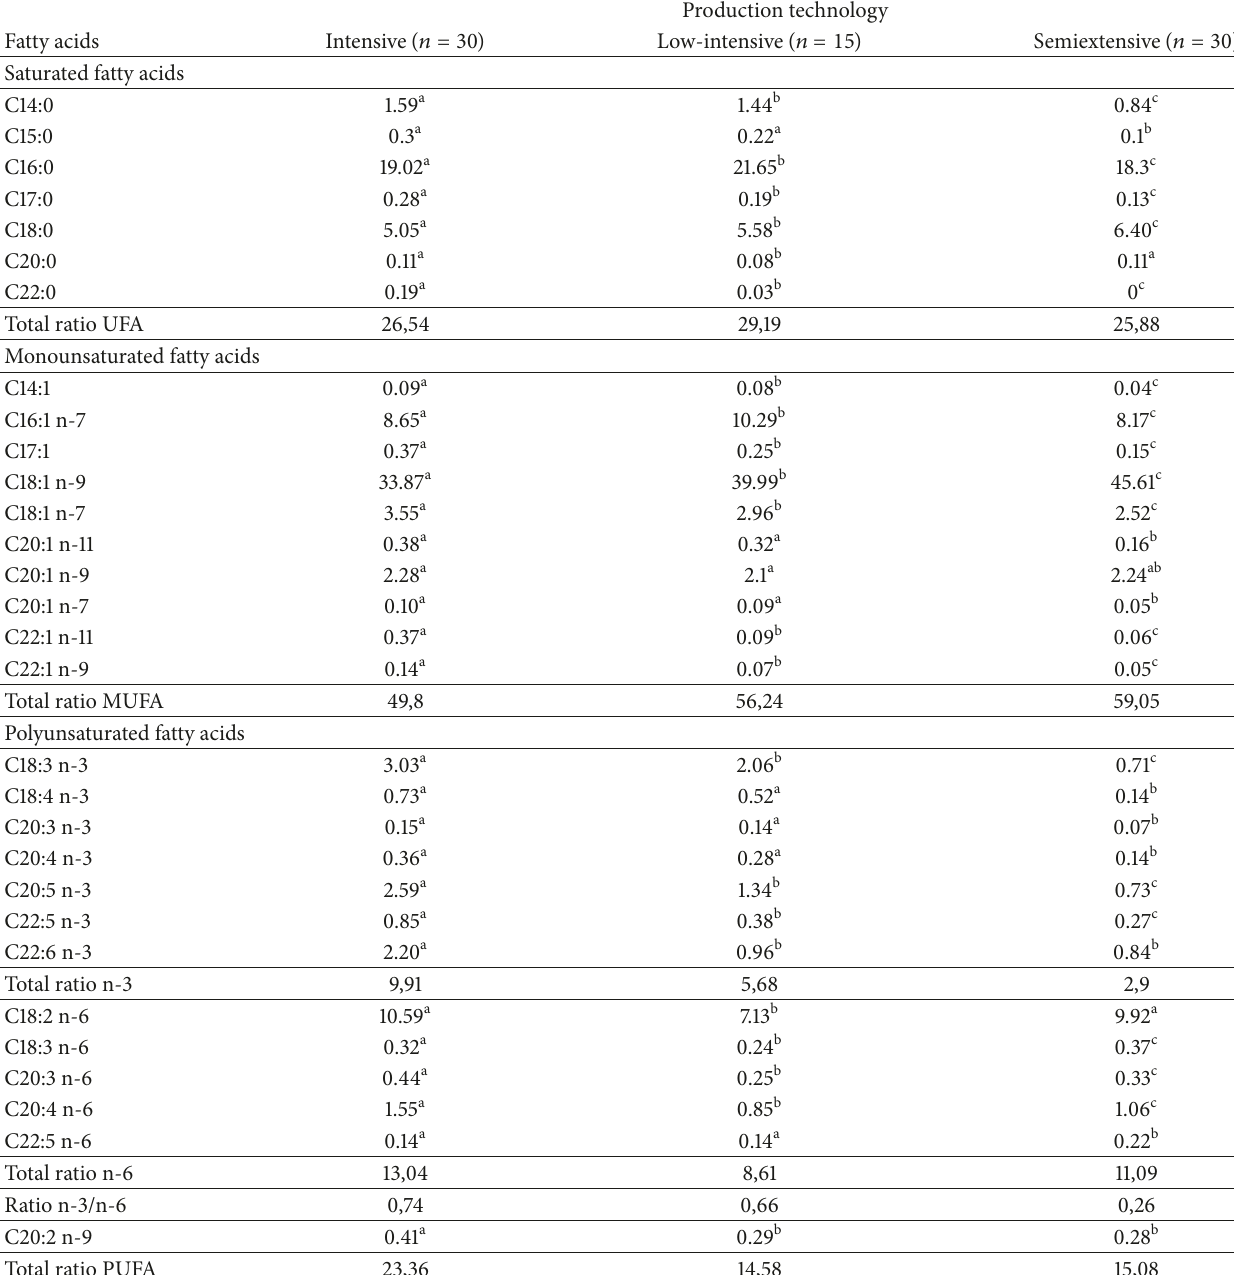
Table 2: Fatty acid profile in muscle tissue of common carp under study (%). Production